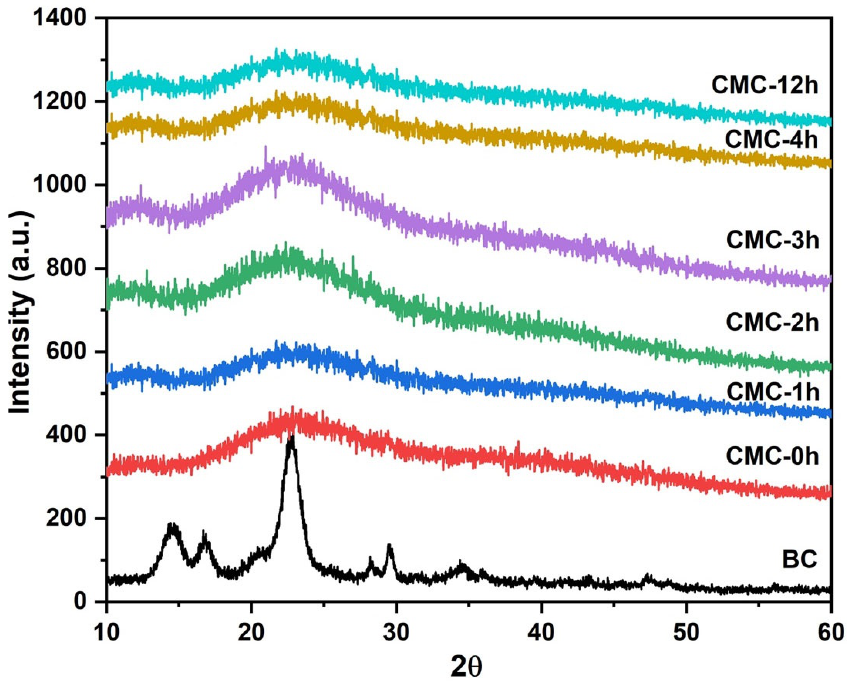
Figure 1. XRD patterns of BC and CMC samples. Figure 2 depicts the FTIR spectra of neat BC and all synthesized CMCs. Typical stretching and vibrational bands of cellulose I appeared for neat BC spectrum at 3405 cm − 1 for O ‐ H stretching, 2895 cm − 1 for C ‐ H stretching, 1647 cm − 1 for H ‐ O ‐ H bending vibration of absorbed water molecules; 1427 cm − 1 for CH 2 symmetrical bending, 1164 cm1 for C ‐ O ‐ C bond; 1110 cm − 1 for C ‐ O stretching and the band at 897 cm 1 for b ‐ linked glucose polymers [22,23]. After the carboxymethylation of BC, the typical absorption bands of carboxymethyl ether groups centered at 1601 cm − 1 and 1421 cm − 1 were evidenced, which confirms the formation of CMC [12,24]. The peaks are present in all the CMCs.